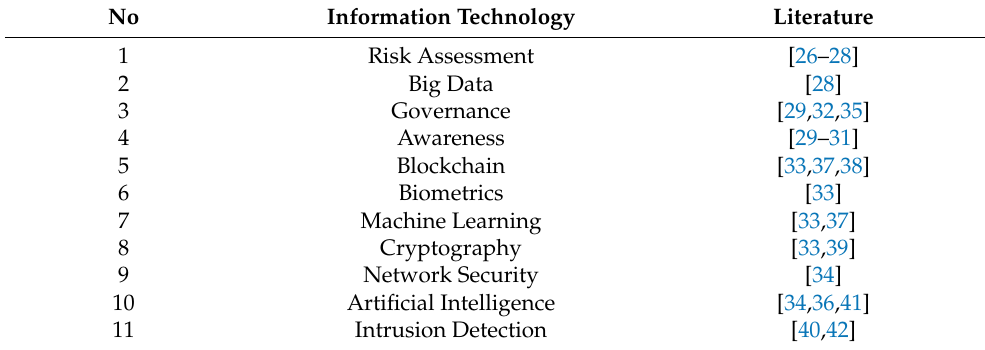
Table 3. Information technology for IKN cybersecurity.